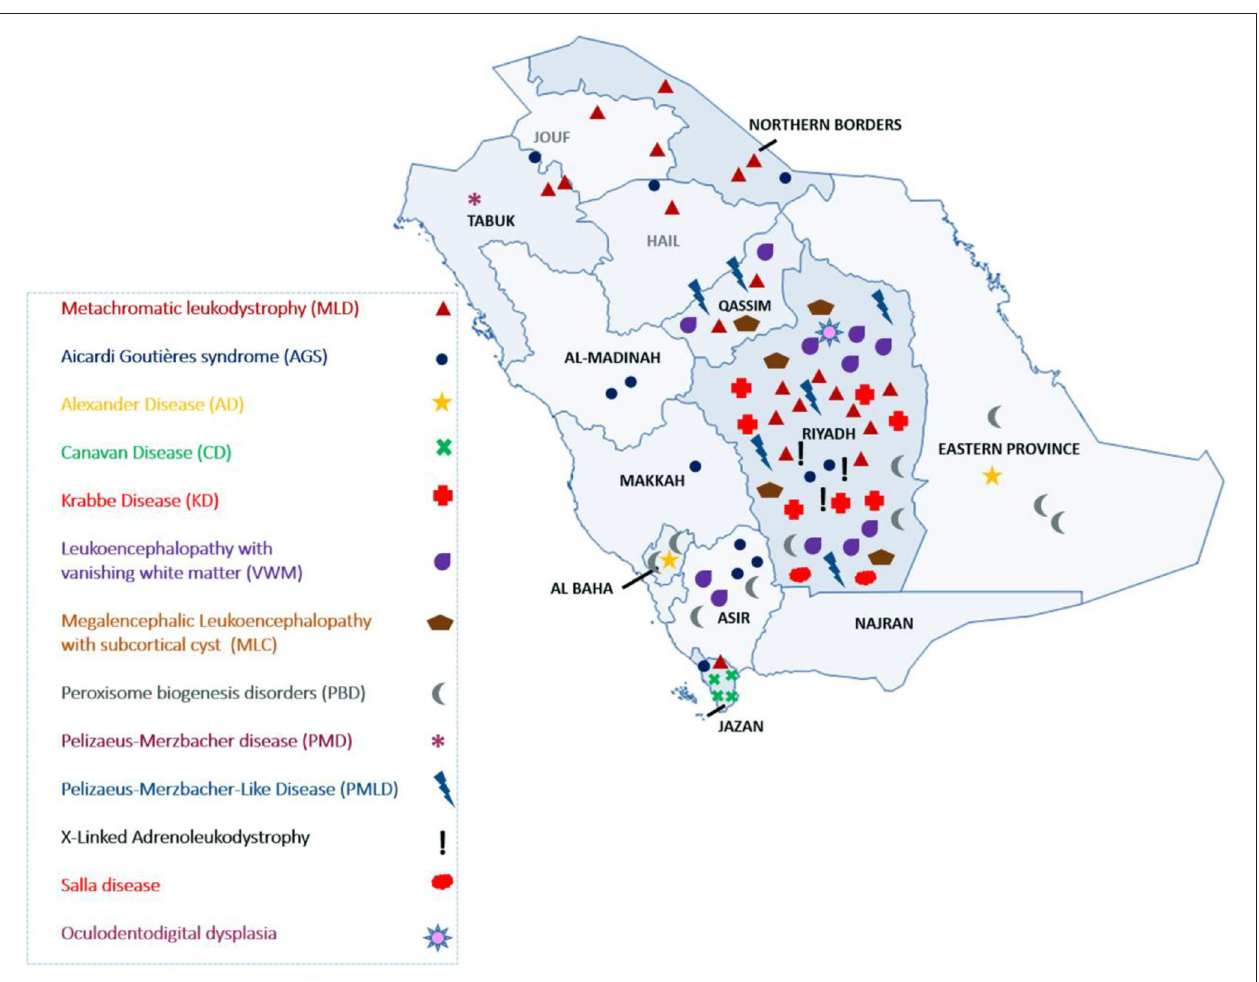
FIGURE 2 | Geographical distribution of LD in Saudi